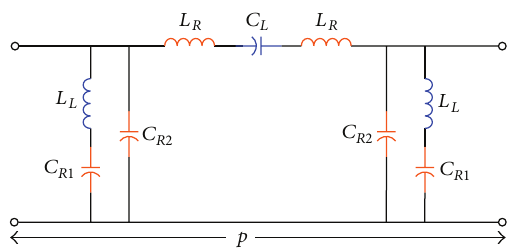
Figure 2: Symmetrical equivalent circuit of the improved CRLH structure.